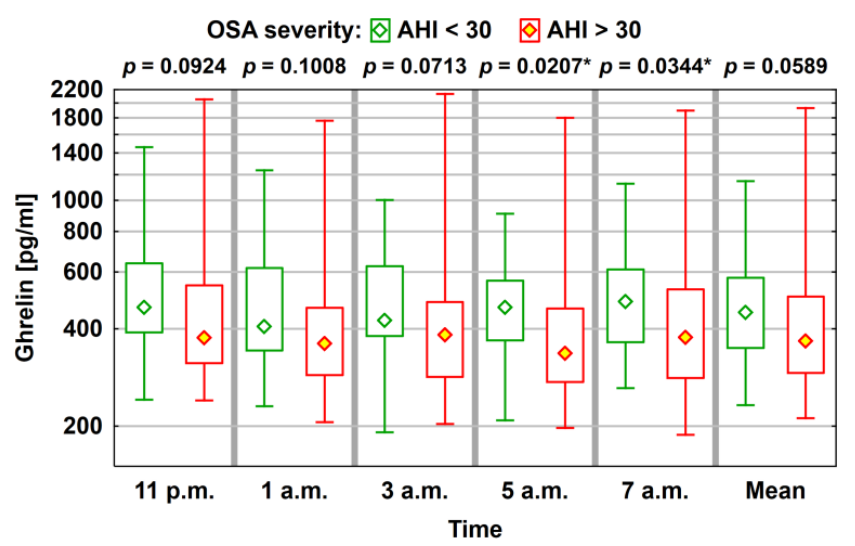
Figure 1. Average level (median) of ghrelin concentration (median) with a typical range of variability (lower and upper quartile) and the total range of variation (statistically significant correlations, where p < 0.05, are marked using *). Table 5. Comparison of ghrelin, obestatin, and leptin levels depending on the severity of OSA (statistically significant correlations, where p < 0.05, are marked using